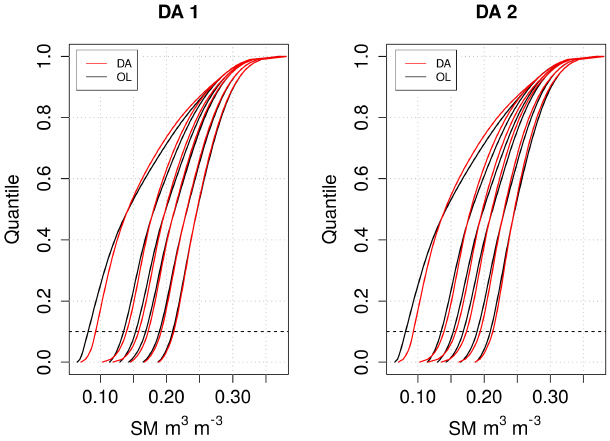
Figure 12. Cumulative distribution functions (CDFs) for the up- per six CLM soil layers for experiments DA 1 and DA 2, based on quantiles computed for all data across the model domain. CDFs for open-loop simulations are shown in black and assimilation re- sults in red. Both panels show changes in CDF behaviour for the layers being updated in the respective experiments, i.e. layers 1–3 for DA 1 and layers 1–6 for DA 2. Soil moisture increases sys- tematically with soil depth allowing for the easy identification of the layers within the plot. The dashed vertical line marks the 10% quantile, corresponding to Figs. 10 and